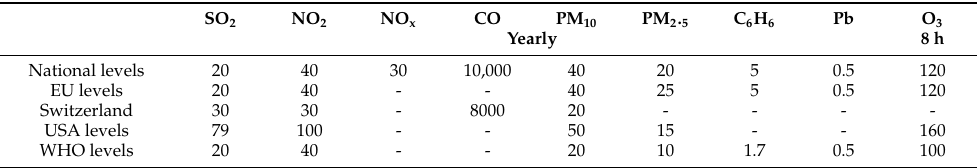
Table 5. Maximum permissible air pollution levels, considering humans and plants protection ( µ g m − 3 )